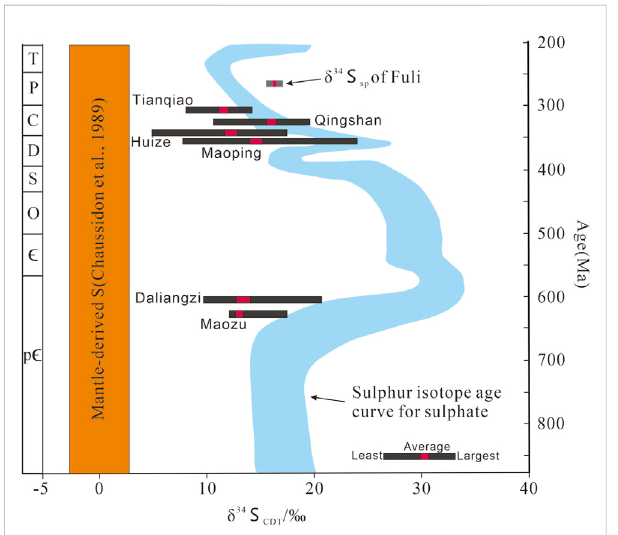
FIGURE 10 The comparison plot of 207 Pb/ 204 Pb vs. 206 Pb/ 204 Pb that display the fi eld of late Permian Emeishan basalts, Cambrian-middle Permian sedimentary rocks and Proterozoic metamorphic rocks, and the Pb evolution curves of U, O, M and L (after Zartman and Doe, 1981); Upper Crust (U), Orogen Belt (O), Mantle (M) and Lower Crust (L). The data sourced from (Huang et al., 2004; Li et al., 2007; Yan et al., 2007; Zhou et al., 2013b; 2014; Bao et al., 2017).